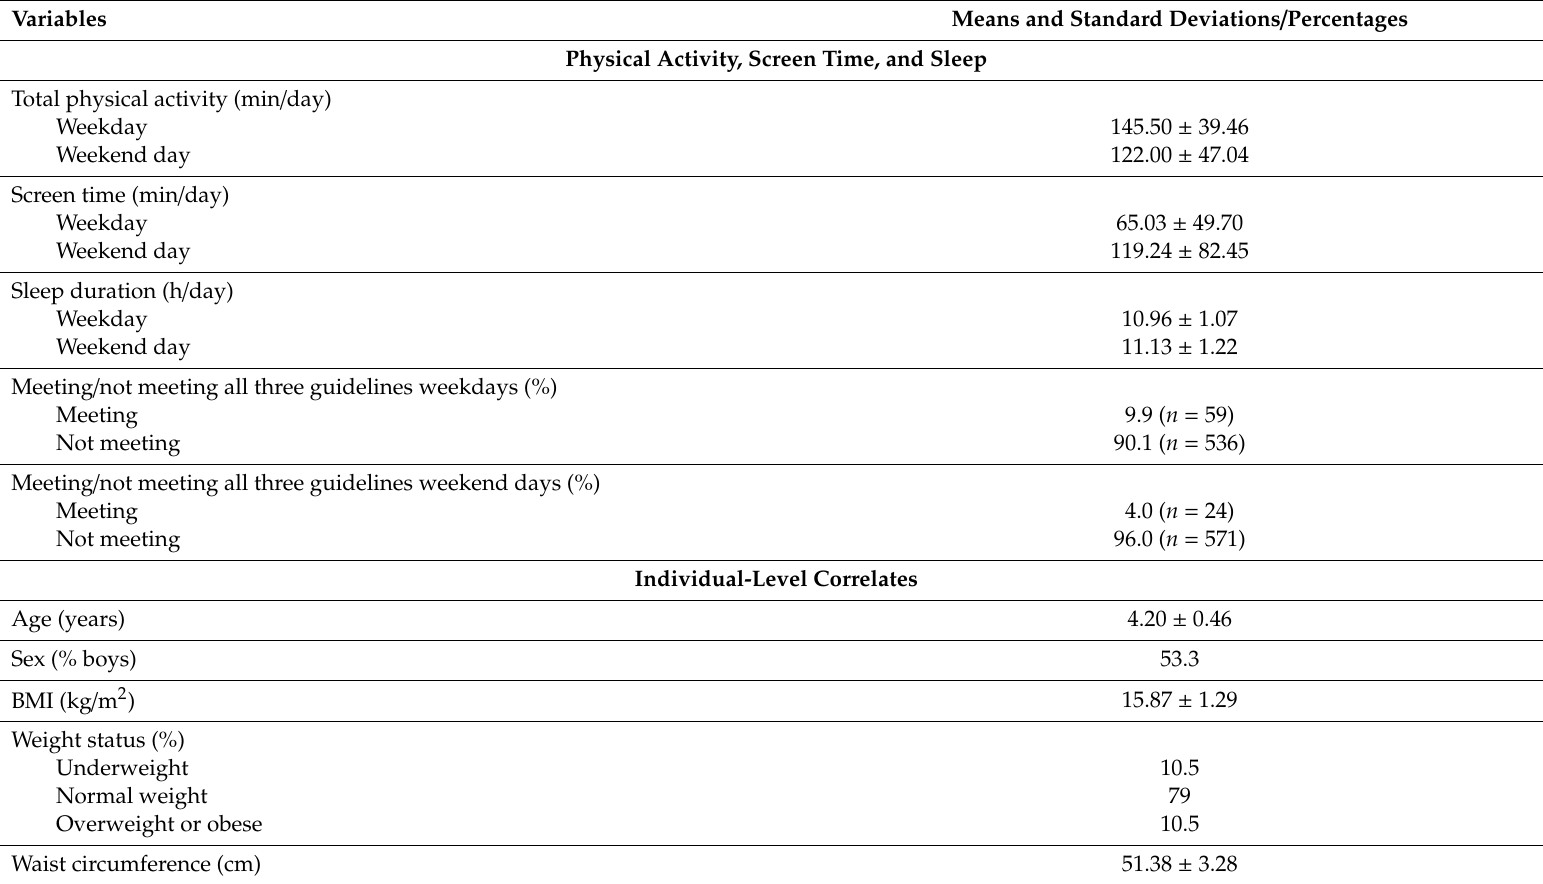
Table 2. Descriptive characteristics of the total sample ( n =